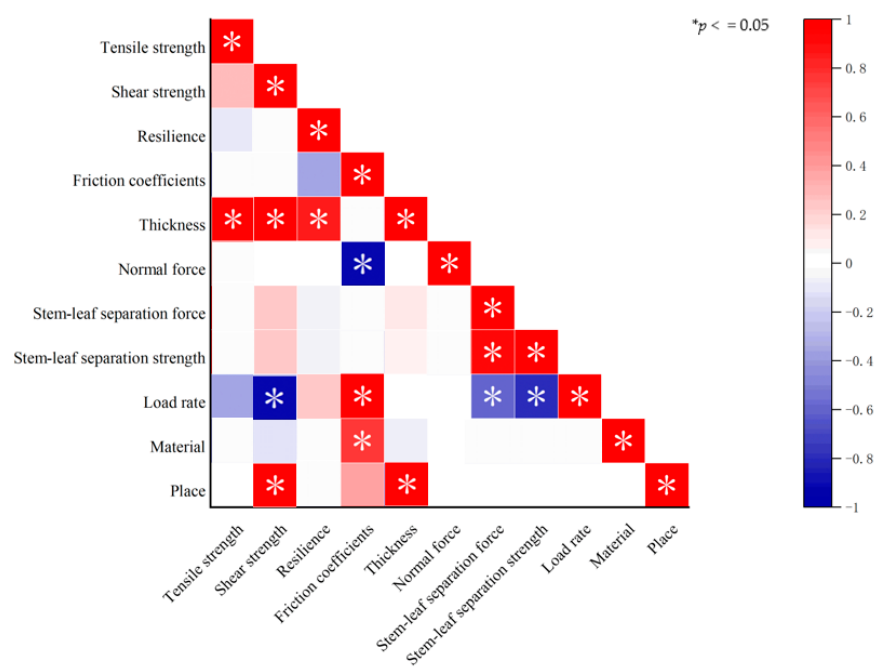
Figure 25. Correlation plot.